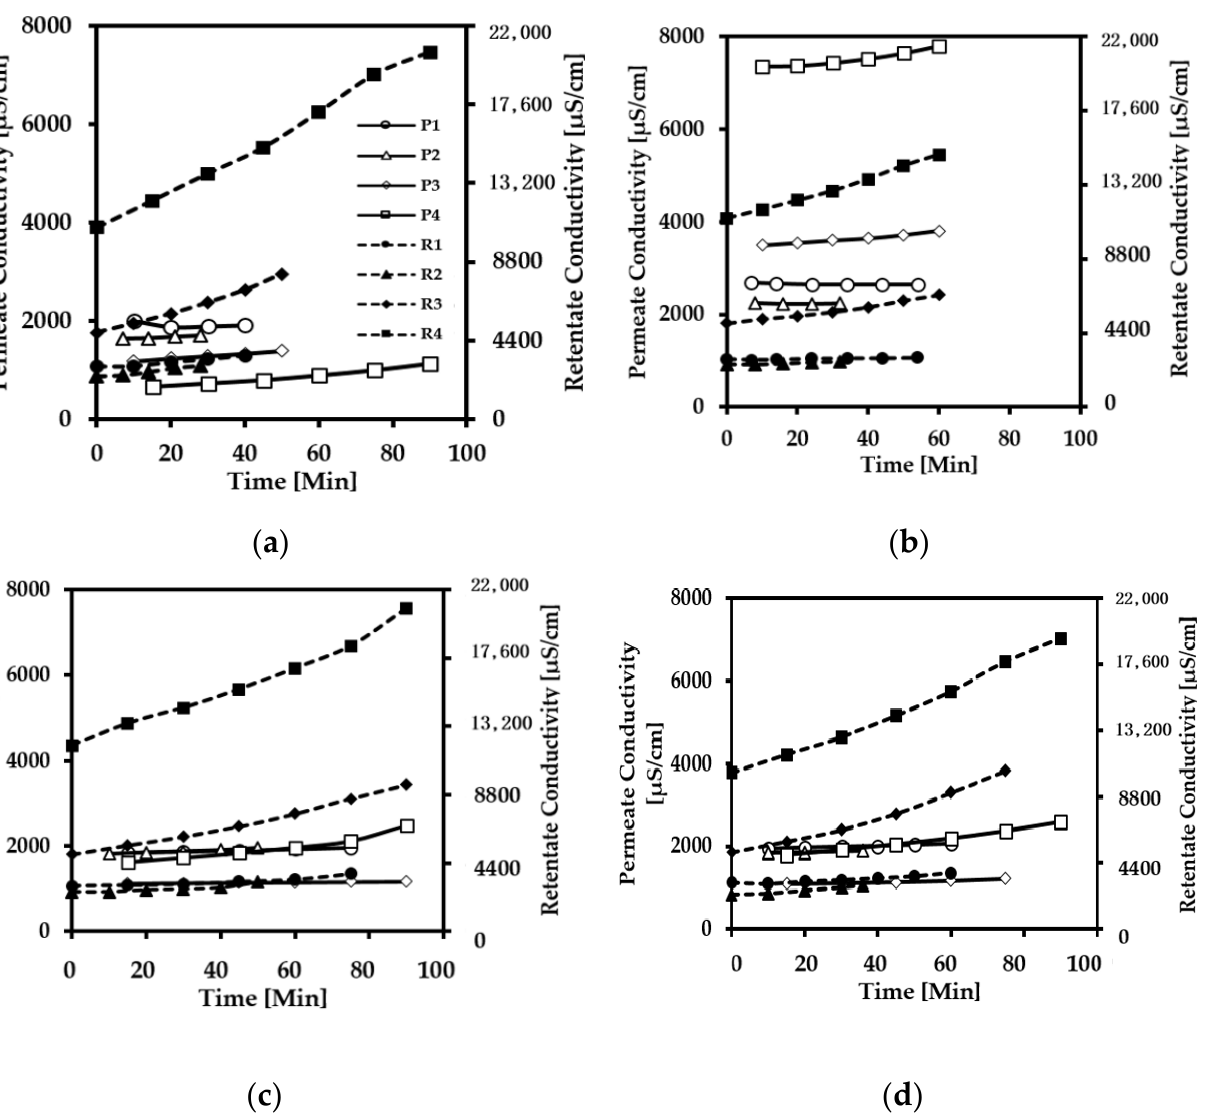
Figure 4. The conductivity of the lactic acid solution thought different membranes: ( a ) NF270, ( b ) SelRO ® MPF-36, ( c ) Toray NF, and ( d ) Alfa Laval NF. P1 and R1, P2 and R2, P3 and R3, and P4 and R4 belong to experiments 1, 2, 3, and 4 listed in Table 3. P is permeate and R is